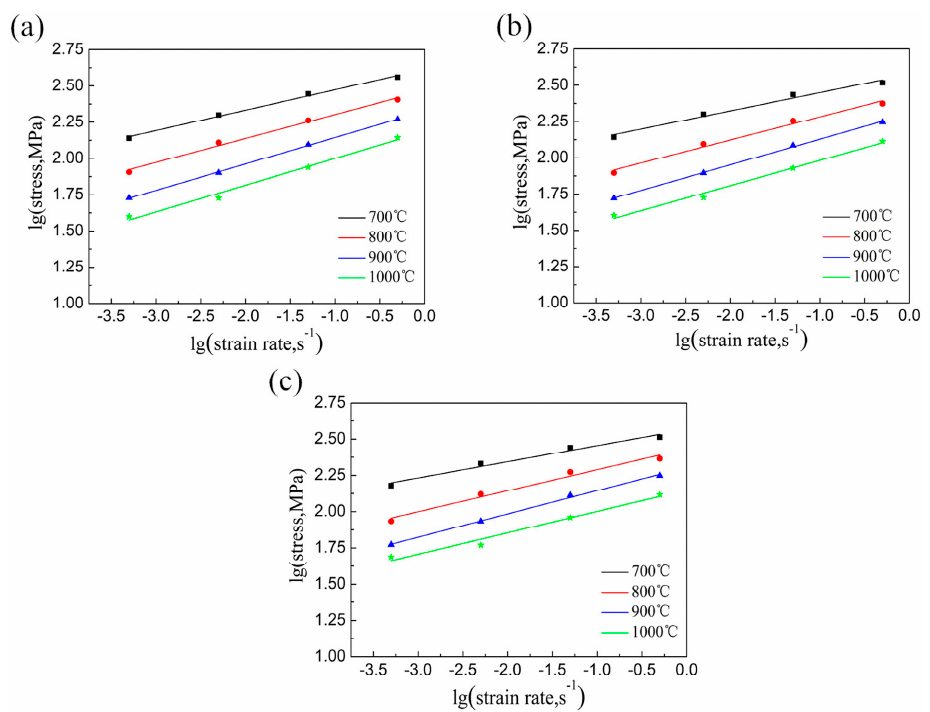
. log σ log ε  ε based on various strains: ( a ) ε = 0.3; ( b ) ε = 0.6; and based on various strains: ( a )